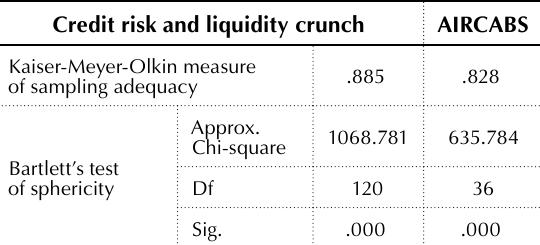
Table 12. KMO and Bartlett’s test Credit risk and liquidity